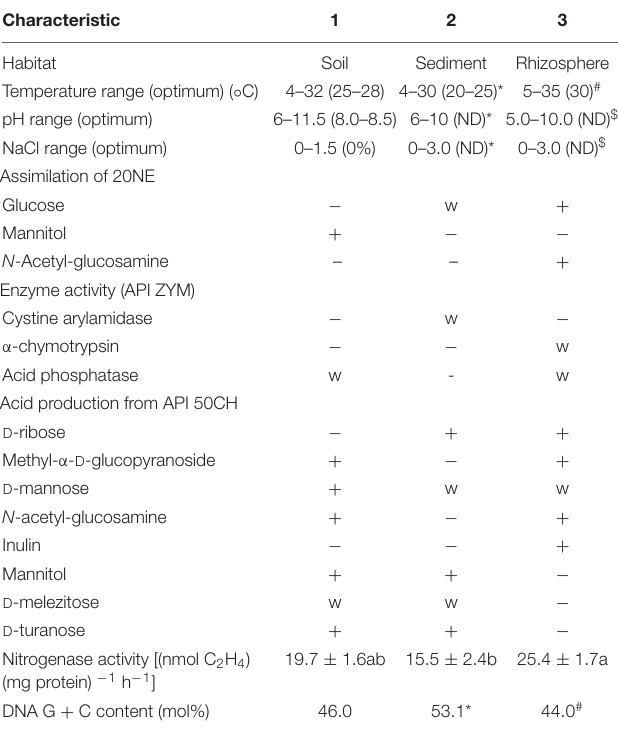
TABLE 3 | Characteristics that differentiate the novel species LC-T2 T from phylogenetically related species of the genus Paenibacillus . Characteristic